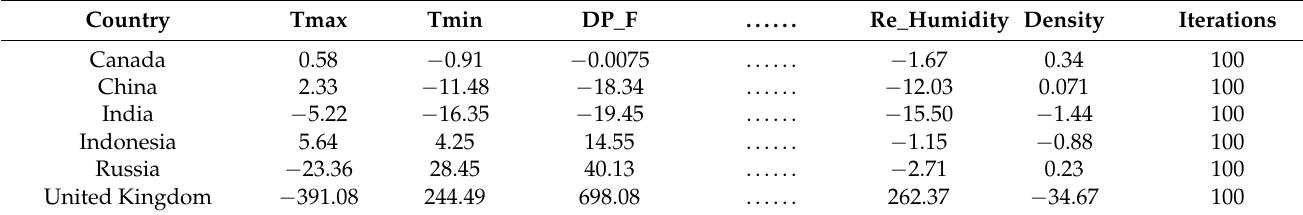
Table 5. Example of initial value of each characteristic coefficient.